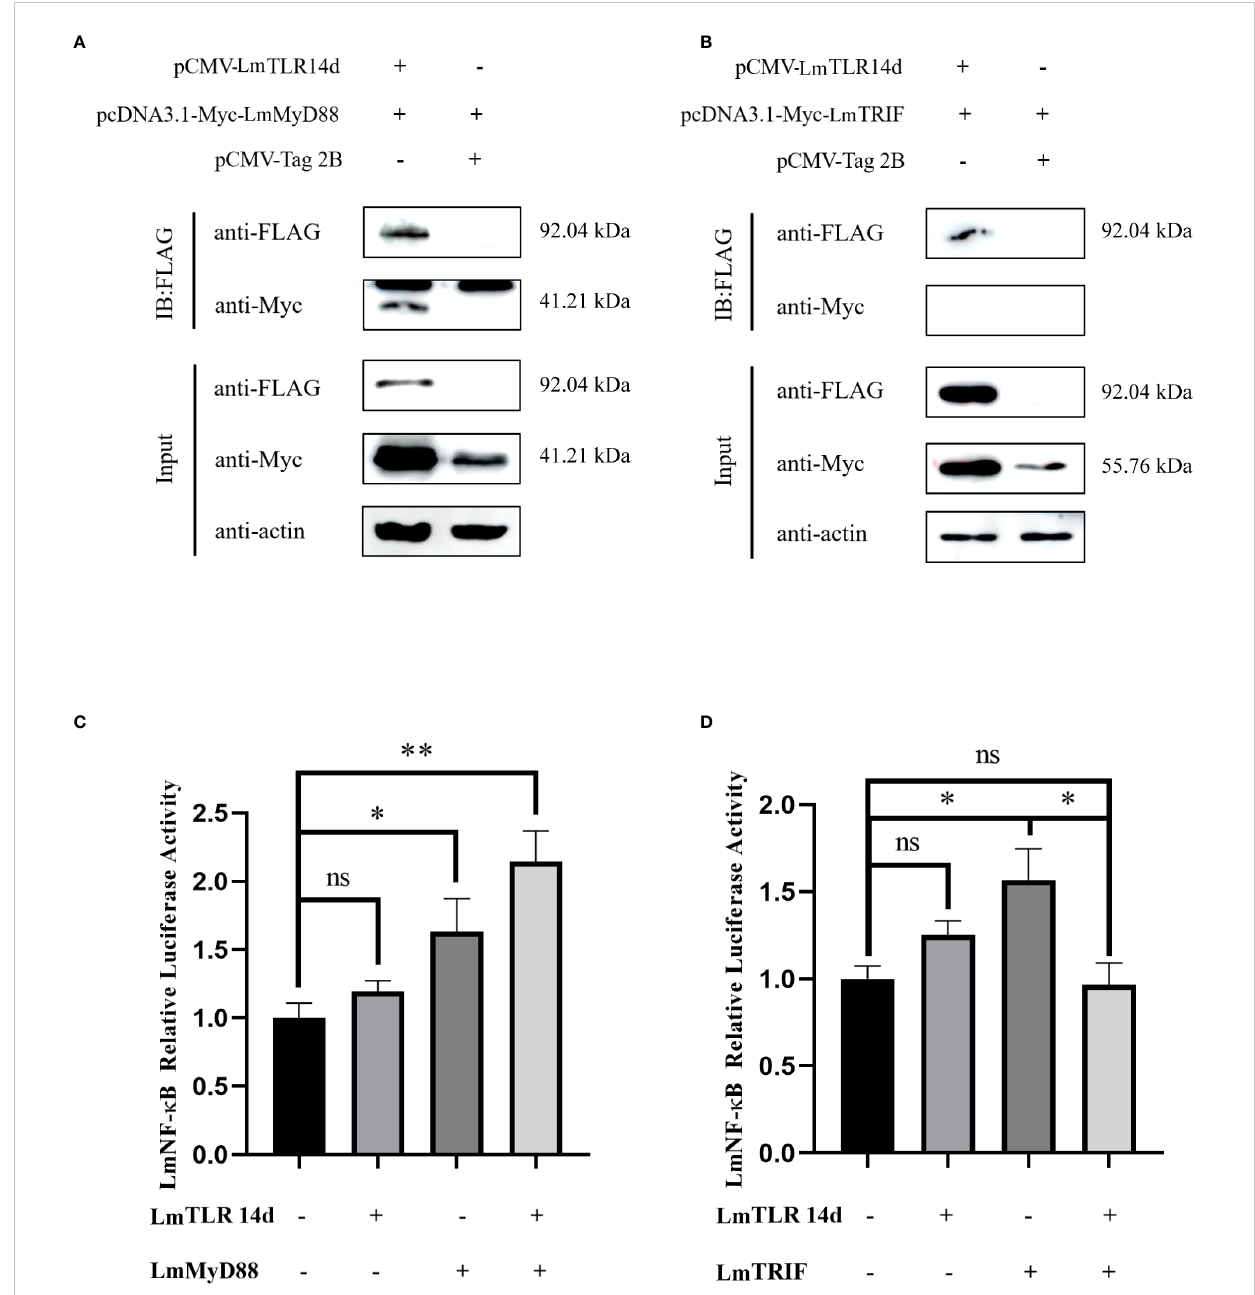
FIGURE 5 Relationship between LmTLR14d and TLR signal-related molecules in lampreys. The physical interaction between LmTLR14d and LmMyD88 (A) , LmTRIF (B) in HEK 293T cells. FLAG-LmTLR14d was co-transfected with Myc-LmMyD88 and Myc-LmTRIF, respectively. Immuno-coprecipitation was performed with protein A magnetic beads that bound anti-FLAG antibodies. b -actin as the internal reference. The samples before and after immunoprecipitation were separated by SDS-PAGE and Western blotting was performed with anti-FLAG or anti-Myc antibodies. (C) The effect of co-transfection of LmTLR14d and LmMyD88 on LmNF-kB. (D) The effect of co-transfection of LmTLR14d and LmTRIF on LmNF- k B. Bars show mean ± SEM. A one-way ANOVA analysis of variance followed by the Bonferroni multiple comparison test. * means signi fi cant difference (n=3, * P <0.05 ** P <0.01). Ns stands for no signi fi cant